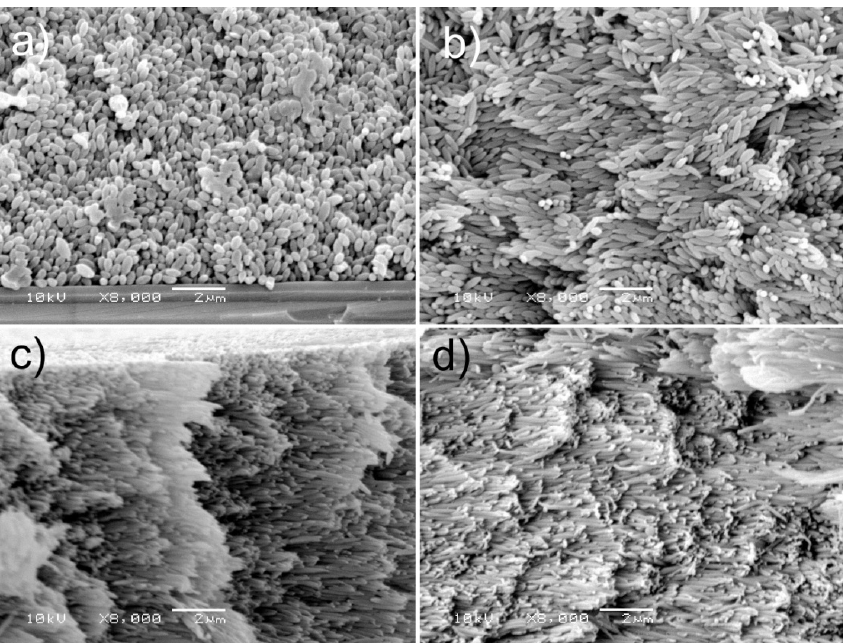
Figure 6. SEM microphotographs of fractures of the P(S/PGL) microspheroid assemblies prepared from particle suspensions in water/ethanol media containing 30% of ethanol. Particle aspect ratio: ( a )—2.17, ( b )—3.89, ( c )—6.41, ( d )—8.50.